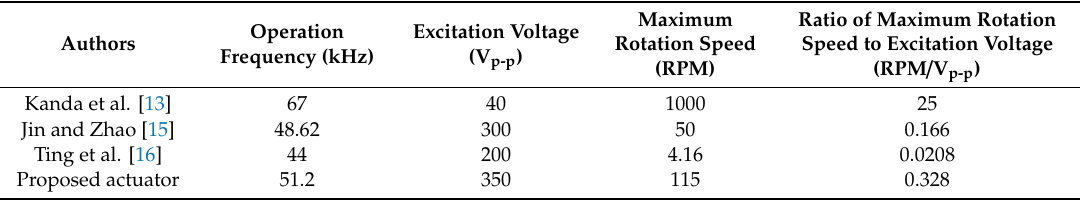
Table 4. Comparison of di ff erent traveling wave